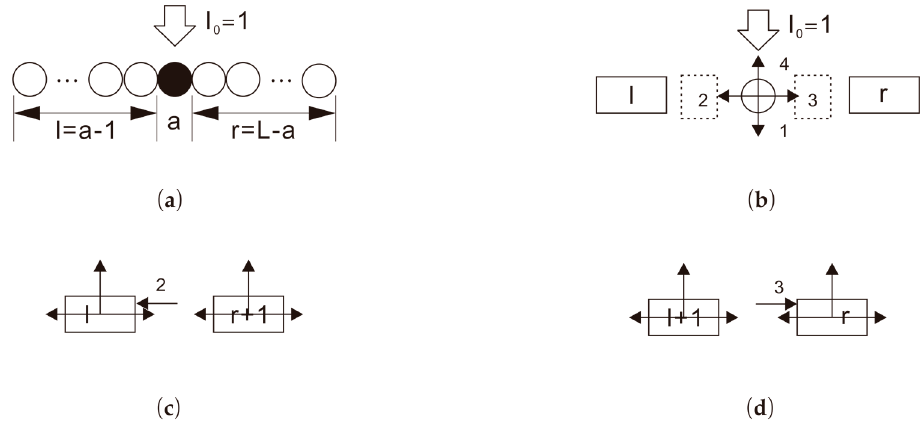
Figure 8. Schematic graphs of radiation transfer in a particle string when light is incident perpendicularly to the string length ( L ). ( a ) real situation when unit radiation is incident on the a th left particle; ( b ) simplified graph when taking left l particles as a block and right r particles as a block; ( c ) simplified graph of radiation transfer for component 2 in ( b ); ( d ) simplified graph of radiation transfer for component 3 in ( b ). I 0 is the incident radiation which is assumed to be a unit.